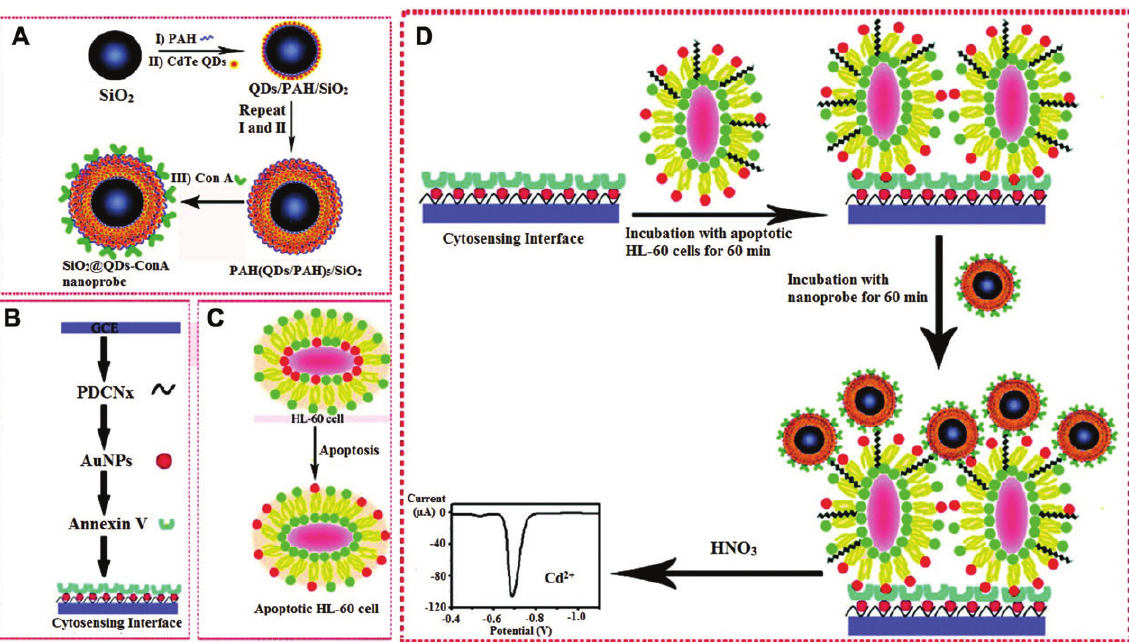
Figure 1 (A) Scheme of the preparation of SiO @QDs-ConA nanoprobe via layer-by-layer assembly. (B) Illustration of the fabrication process 2 of the electrochemical cytosensing interface. (C) Schematic presentation of the exposure of phosphatidylserine residues on the outer surface of the cell membrane during apoptosis. (D) Sandwich electrochemical strategy for the detection of apoptotic cells. (Reproduced with permission from Zhang et al. 2011b